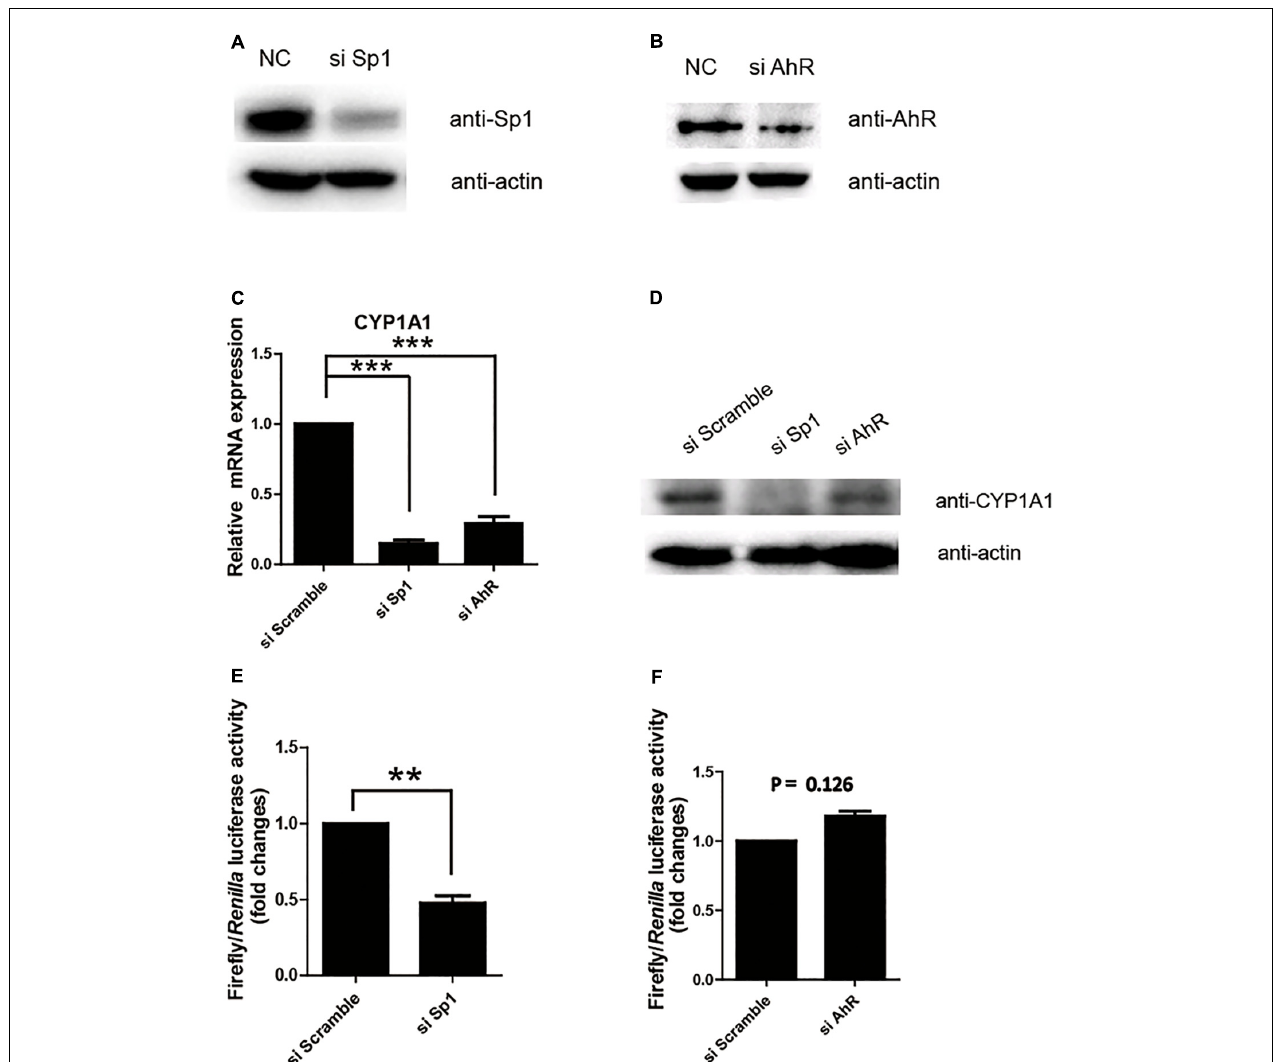
FIGURE 2 | Sp1 is required for the basal transactivation of the proximal promoter of p CYP1A1 . (A,B) Western blotting confirmed Sp1 or AhR protein levels after siRNA transfection in LLC-PK1 cells. (C,D) mRNA and protein levels of pCYP1A1 in the cells with knocked down Sp1 or AhR. RT-PCR confirmed the p CYP1A1 mRNA levels after transfection of siRNA. Western blotting confirmed the pCYP1A1 protein levels after transfection of siRNA. (E,F) Sp1 but not AhR affects the proximal promoter activity of p CYP1A1 . The siRNA, pRL-CMV plasmid and -43-Luc plasmid were co-transfected into LLC-PK1 cells. Non-targeting siRNA (NC) was used as the negative control. The promoter activity of the -43-Luc plasmid was measured. The value on the ordinate indicates the ratio of the value of the promoter activity transferred to the si Sp1 or si AhR to the value of the initiation activity transferred to the NC. The experiment was repeated three times. Error bars represent the standard deviation of three replicates. ∗∗ P < 0.01 and ∗∗∗ P < 0.001.